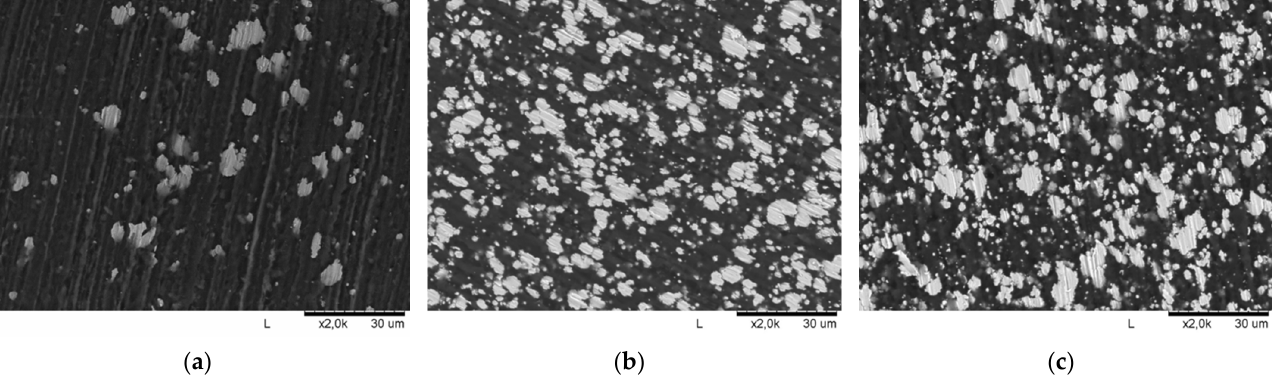
Figure 6. SEM images of the composite filaments: ( a ) PLA-Ni 5%; ( b ) PVB-Ni 25%; ( c ) ABS-Ni 25%.